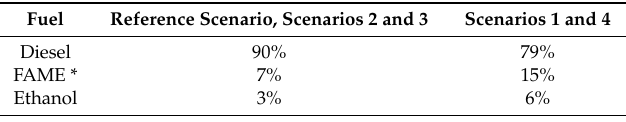
Table A6. Average fuels mix for trucks for the different scenarios.